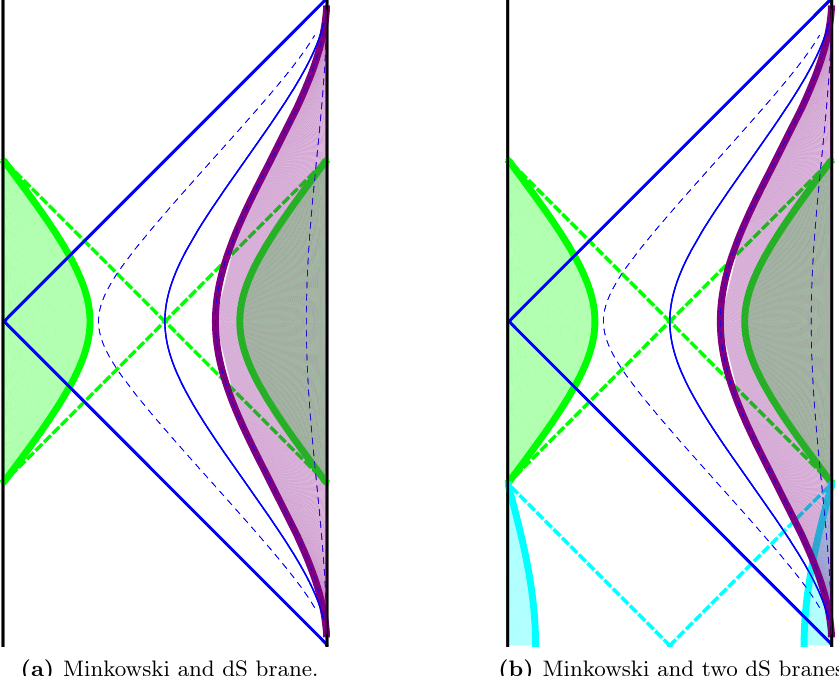
Figure 7. Vertical cross sections of mismatched branes involving dS